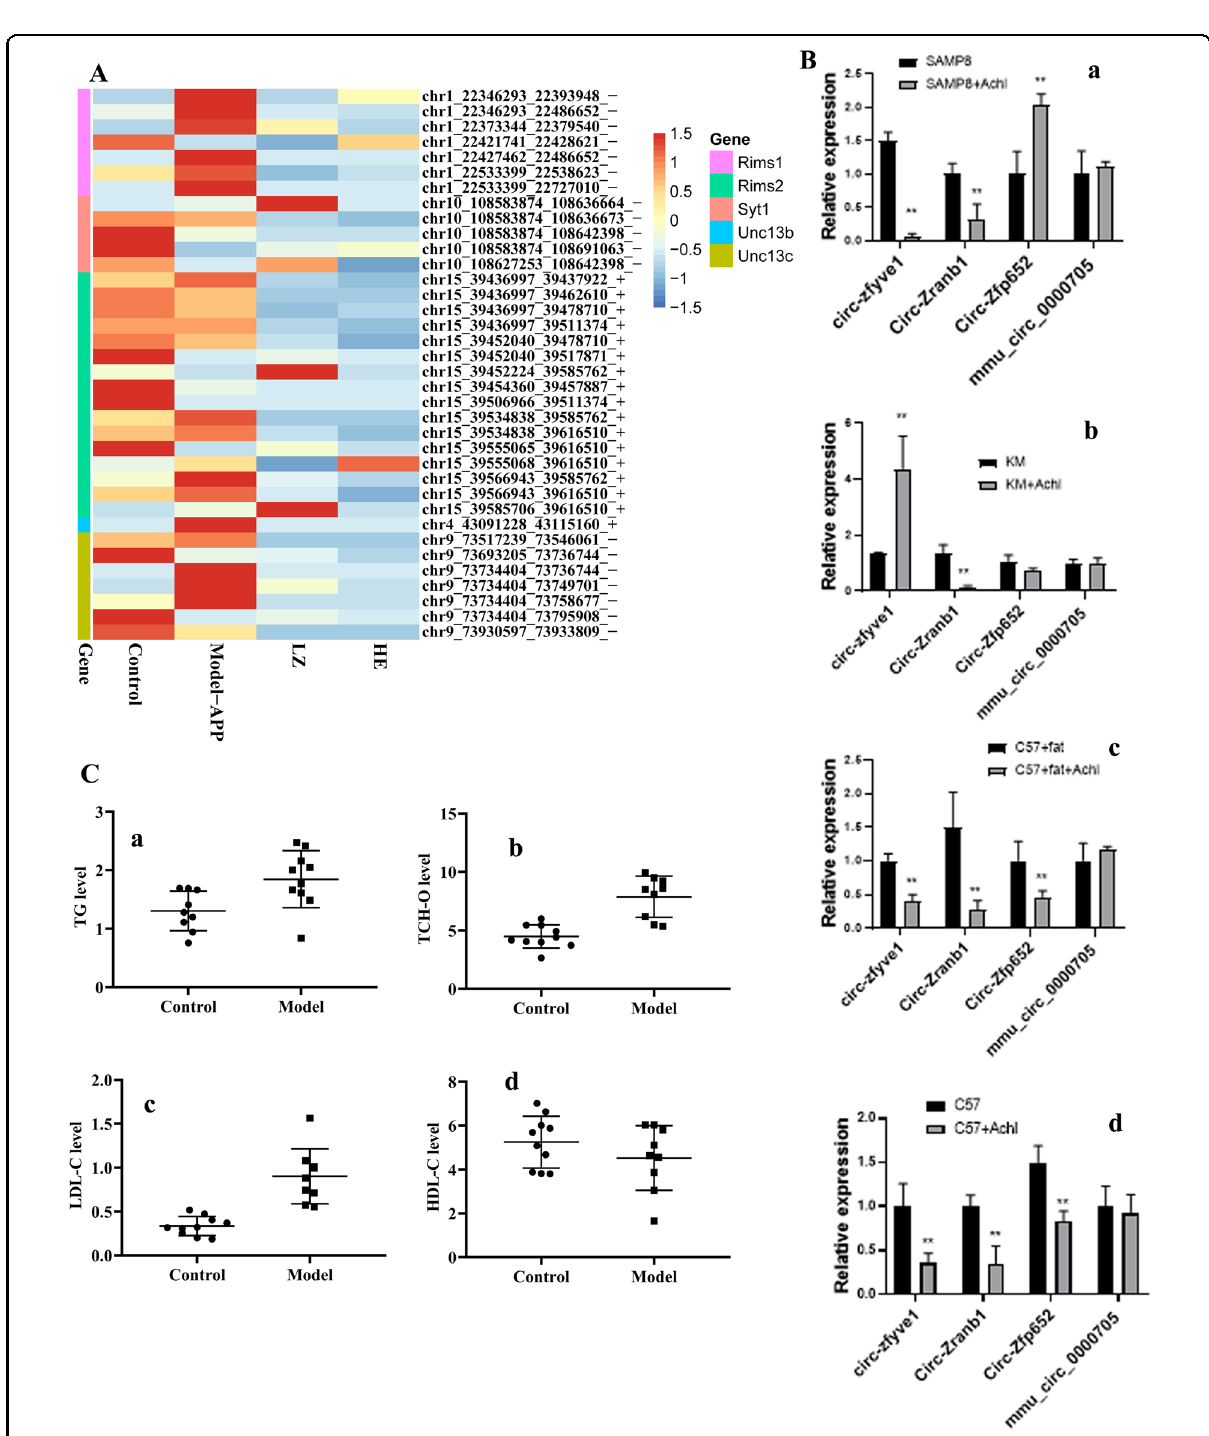
Fig. 7 Effects of choline on circRNA expression and lipid metabolism. A Relative expression of circRNAs spliced from Rims1/Syt1/Unc13b enriched in the acetylcholine release cycle. B Expression of circRNAs in choline-treated mice using RT-qPCR. C Levels of total cholesterol (T-CHO), triglyceride (TG), low-density lipoprotein (LDL), and high-density lipoprotein (HDL) in mice fed a diet high in sugar and fat. Data are the mean ± SD of more than 6 independent experiments. * p < 0.05 and ** p < 0.01 vs . the model group by one-way ANOVA, followed by the Holm – Sidak